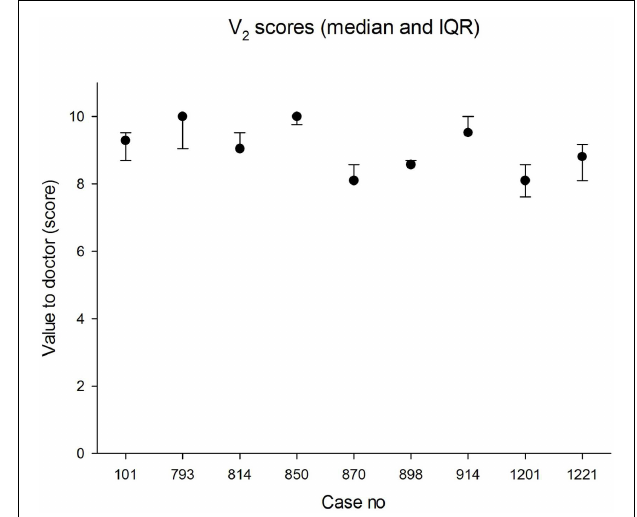
FIGURE 3 | Median scores for value to referrer (0 = worst; 10 = best) . The error bars indicate the 25th and 75th percentiles.